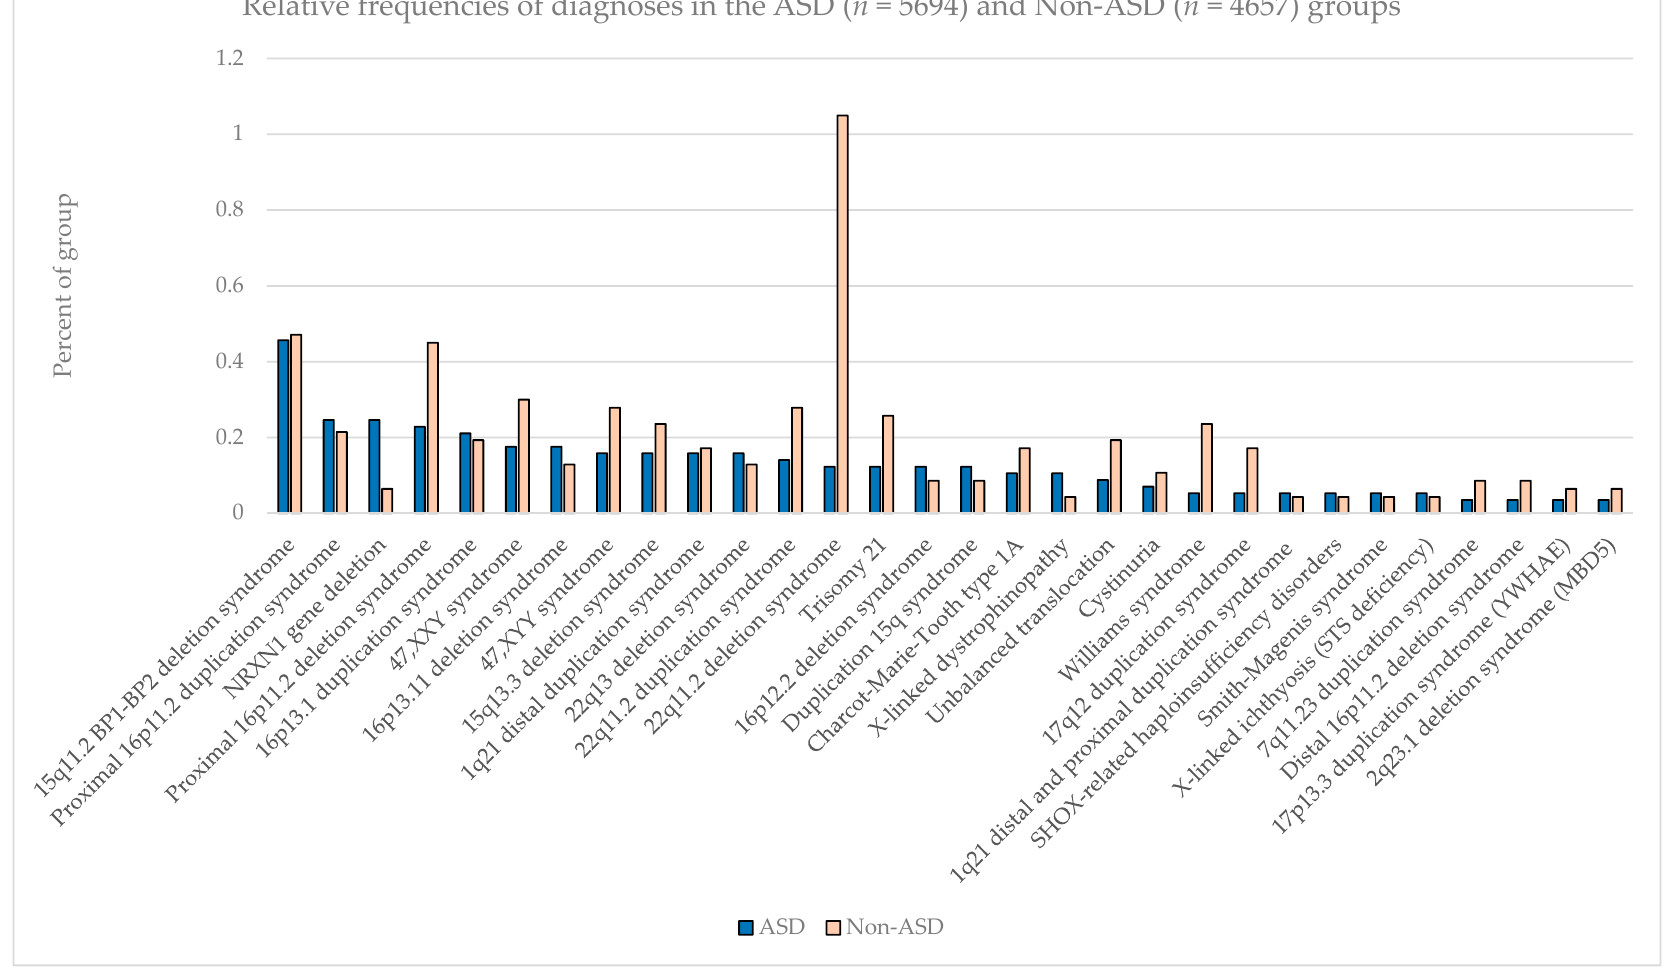
Figure 1. Relative frequencies of diagnoses in the combined ASD ( n = 5694) and Non-ASD ( n = 4657) groups.